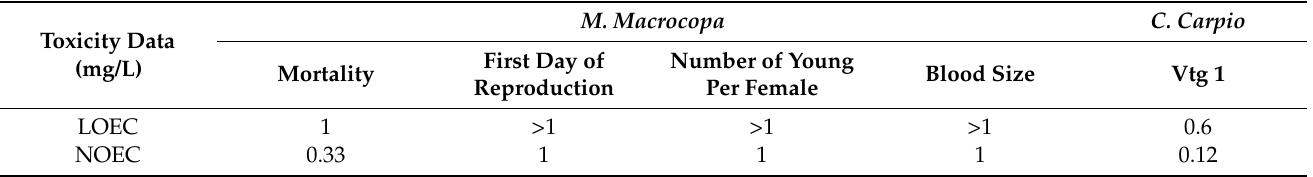
Table 3. Lowest observed effect concentration (LOEC) and no observed effect concentration (NOEC) of benzophenone-3 to Moina macrocopa and Cyprinus carpio in the chronic toxicity tests. Toxicity Data